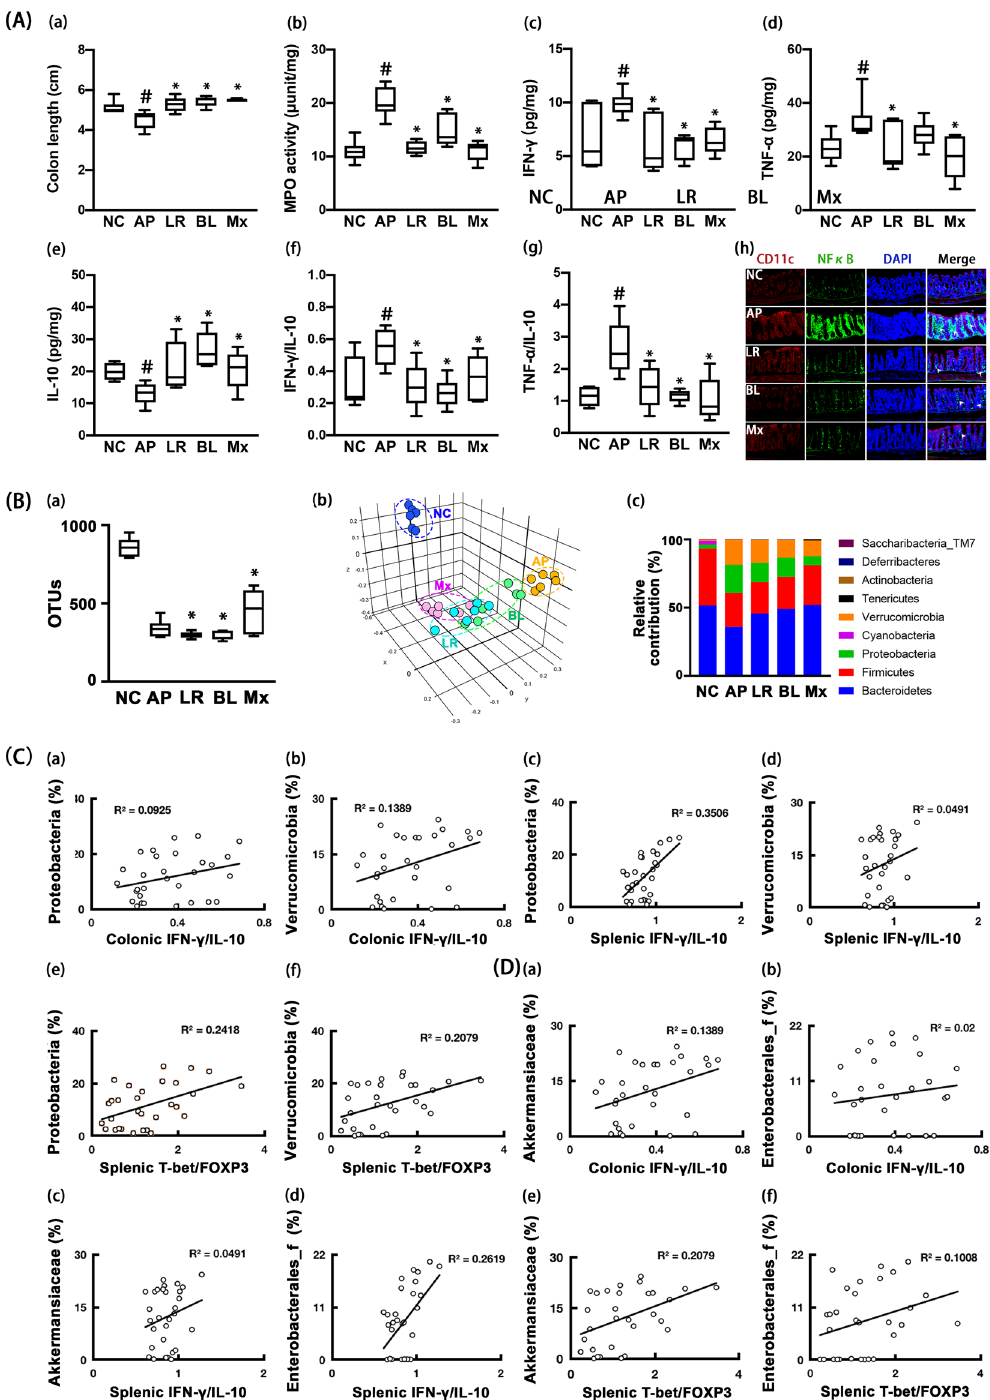
Figure 4. Effects of NK210 and NK219 on ampicillin-induced gut dysbiosis and inflammation in mice. ( A ) Effects on colitis: colon length (a), myeloperoxidase (MPO) activity (b), IFN-γ (c), TNF-α (d), IL-10 expression (e), IFN-γ to IL-10 expression ratio (f), TNF-α to IL-10 expression ratio (g), and NF-κB + /CD11c + cell population in the colon (h). ( B ) Effects on the gut microbiota composition: (a) α-diversity (OUT richness, a), (b) β-diversity (PCoA plot based on Jensen-Shannon analysis), and (c) gut microbiota composition at the phylum level. The correlation between gut microbiota and IFN-γ to IL-10 or Tbet to Foxp3 expression ratio at the phylum ( C ) and family levels ( D ). Test agents (AP, ampicillin alone; LR, 1 × 10 9 CFU/mouse/day of NK210; BL, 1 × 10 9 CFU/mouse/day of NK219; Mx, 1 × 10 9 CFU/mouse/day of LR and BL [4:1] mix) were orally gavaged daily for 5 days after oral gavage of ampicillin. Normal control mice (NC) were treated with vehicle (saline) instead of test agents. Data values indicate mean ± SD (n = 8). # p < 0.05 versus NC group. * p < 0.05 versus AP group treated with ampicillin